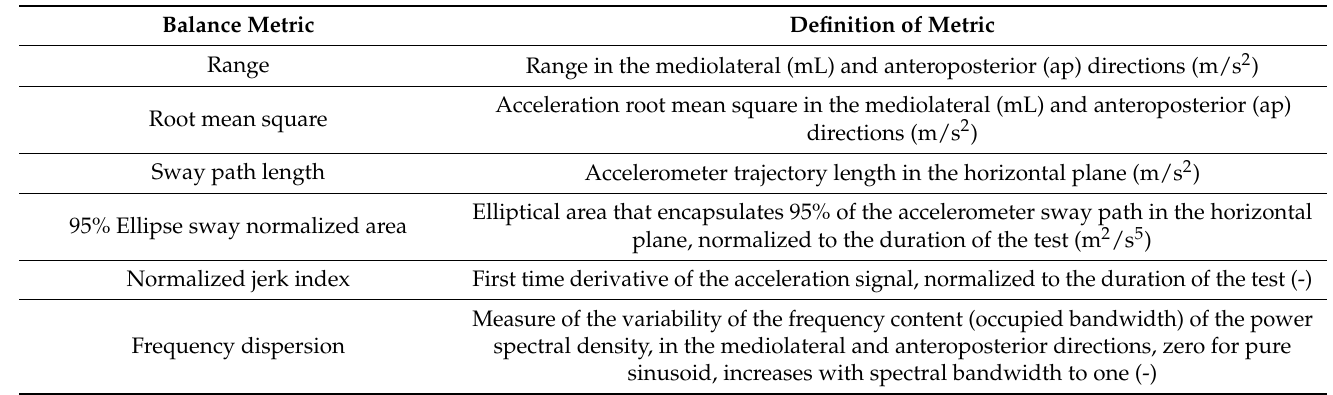
Table 3. Postural stability metrics computed from accelerometry signals collected at the waist. Balance